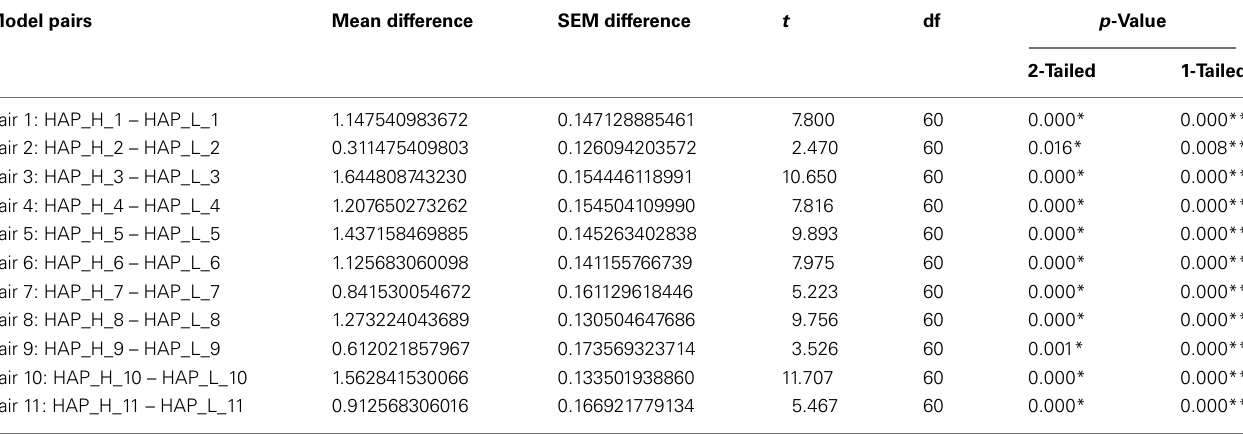
TableA1 | Results from post hoc stimulus validation analysis.